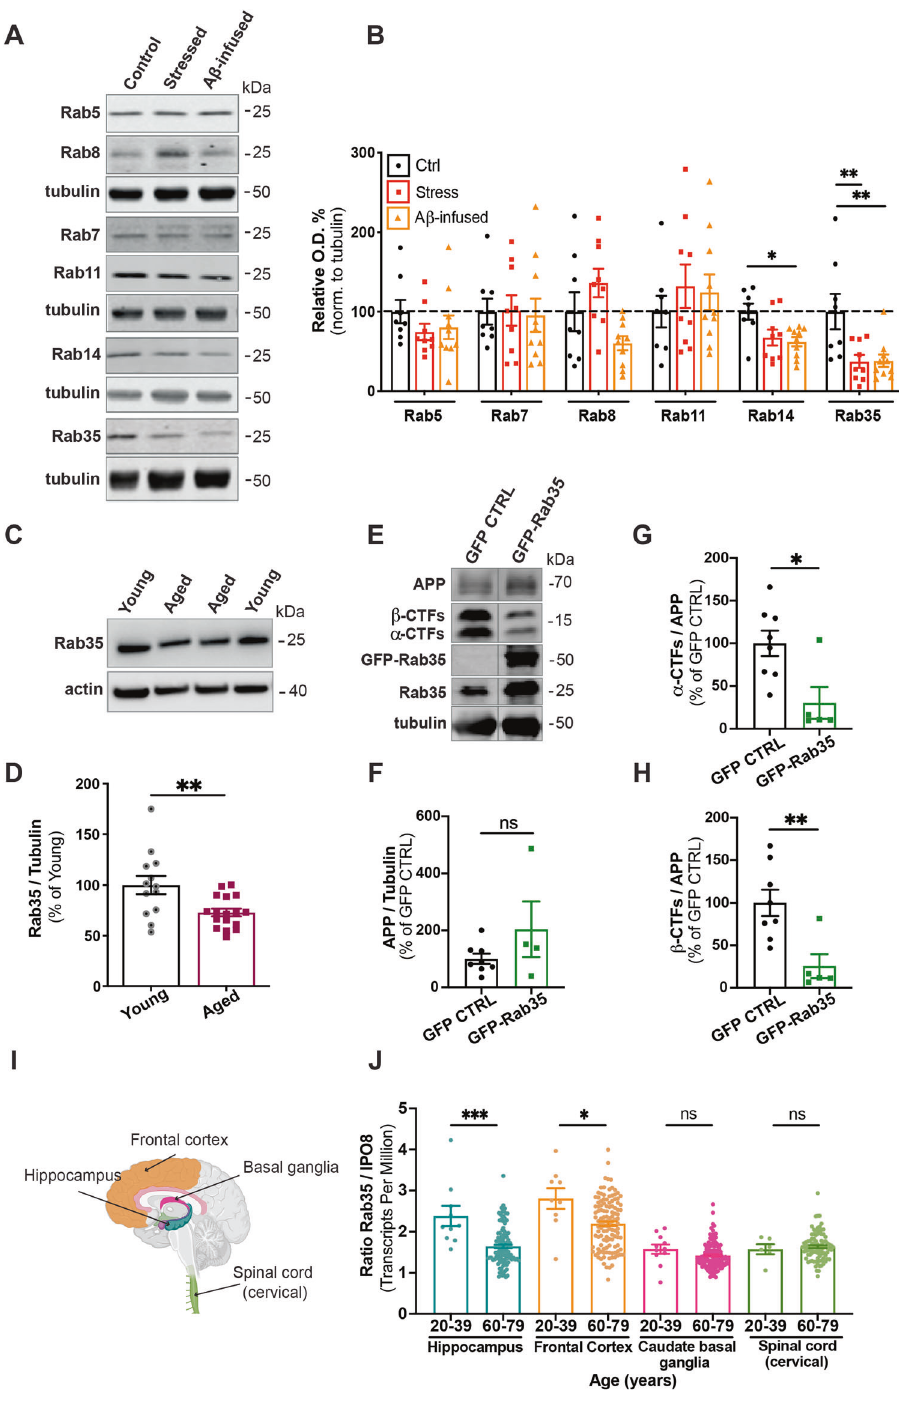
Fig. 1 Hippocampal Rab35 levels are decreased by chronic stress and aging. A , B Representative immunoblots and quanti fi cation of Rab protein levels in the hippocampus of control (Ctrl), stressed, and A β -infused rats. Blots were probed for the noted Rabs and tubulin, with values normalized to tubulin and expressed as % of the control condition (dotted line)(** P Rab35 CON vs. stressed = 0.0075, * P Rab14 CON vs. A β -infused = 0.0228, ** P Rab35 CON vs. A β -infused = 0.0069; one-way ANOVA, Dunnet post hoc analysis, n = 8 – 10 animals/condition). C , D Representative immunoblots and quanti fi cation of Rab35 levels in the hippocampus of young (4 month old) and aged (22 – 24 month old) rats. Blots were probed for Rab35 and actin, with values normalized to actin and expressed as % of young animals (** P = 0.0056; unpaired t -test, n = 13 – 17/condition). E – H Representative immunoblots and quanti fi cation of full-length APP ( F ) and α -C-terminal and β -C-terminal fragments (CTFs) relative to full- length APP ( G , H ) in the dorsal hippocampus of rats bilaterally injected with AAV-GFP or AAV-GFP-Rab35. Blots were probed for APP, Rab35, and tubulin, with values normalized to tubulin and expressed as % of GFP control condition (* P = 0.017, ** P = 0.0048; Welch ’ s unpaired two-tailed t -test, n = 4 – 8 animals/condition). I Schematic diagram of human brain areas used for the analysis of transcriptome data from the Genotype- Tissue Expression (GTEx) project, created with BioRender. J Quanti fi cation of Rab35 mRNA transcripts from individuals ages 20 – 39 years and 60 – 79 years, normalized to IPO8 (* P = 0.0155, ** P = 0.0003; Mann – Whitney test, n = 6 – 135 samples/condition). All numeric data represent mean ±